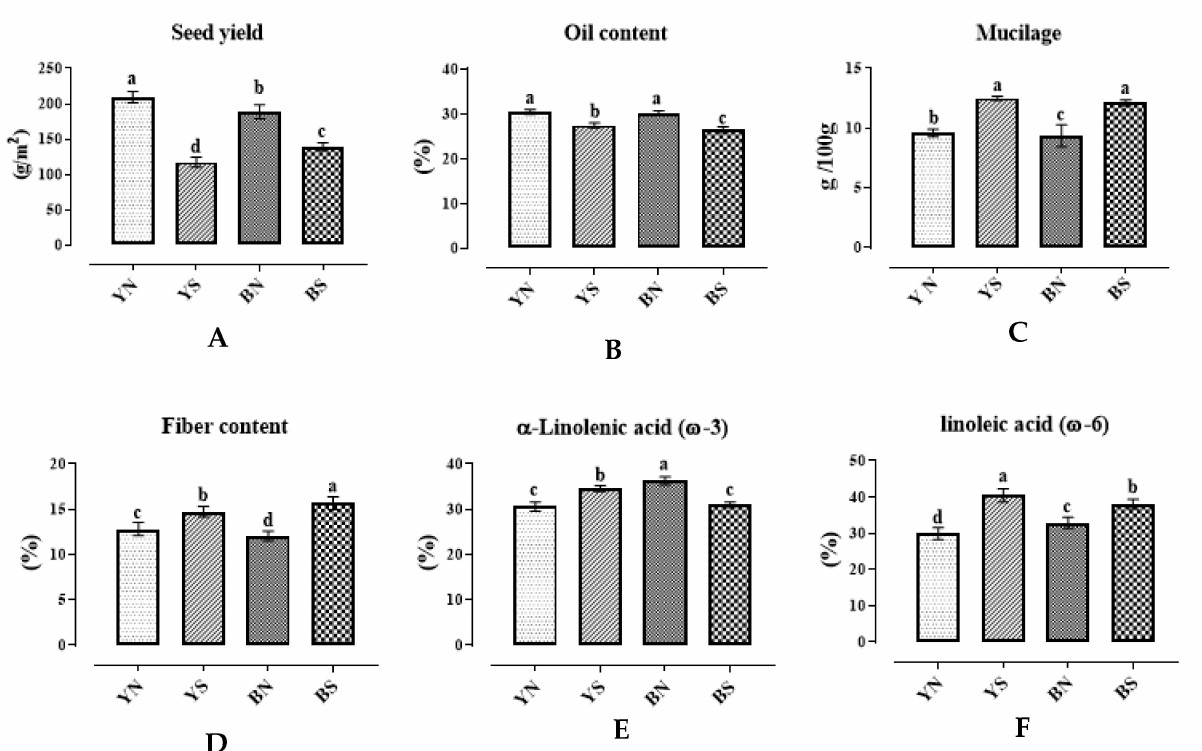
Figure 1. Diagrams of seed yield ( A ), oil content ( B ), mucilage ( C ), fiber content ( D ), α - Linolenic acid (omega-3) ( E ), and linoleic acid (omega-6) ( F ) extracted from flax families under water stress and normal irrigation conditions. A same letter above the columns for each trait (diagram) indicates that the values are not statistically different ( p > 0.05). Values are mean ± standard error. Letters y, b, n, and s denote yellow color, brown color, normal conditions, and water stress conditions,